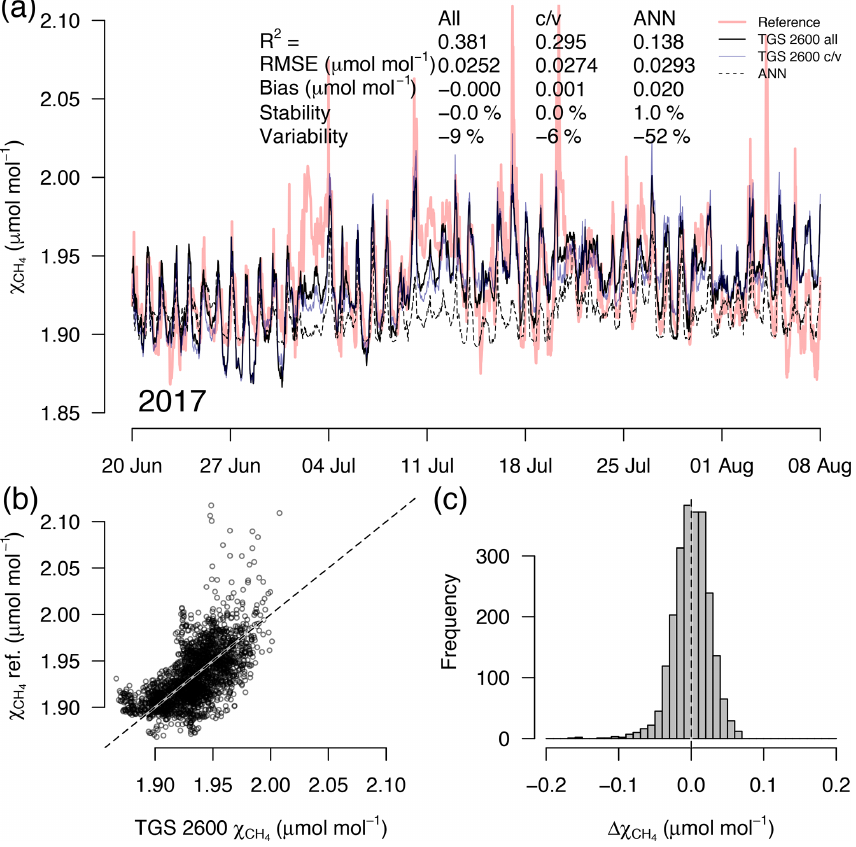
Figure 6. As in Fig. 5 but with measurements from a 7-week snow- and ice-free period in 2017 at a sensor age of 7 years. This example belongs to the validation period of the TGS 2600 c/v and ANN